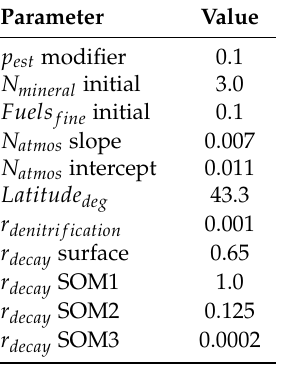
Table A8. NECN adjustment